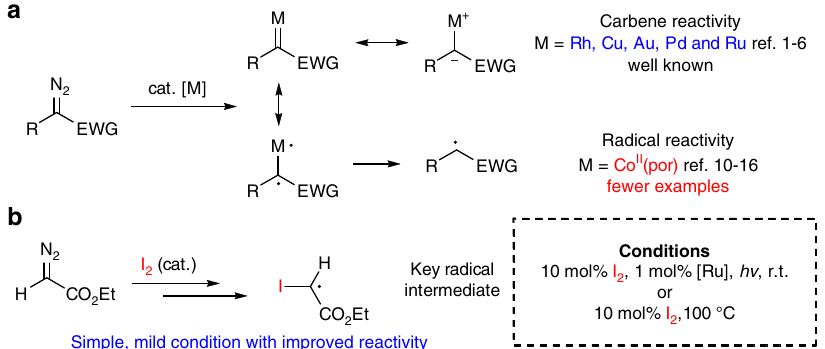
Fig. 1 Catalytic diazo compound activation: carbene vs. radical. a Metal-catalyzed diazo compound activation. b This work: access diazo radical reactivity through simple iodine